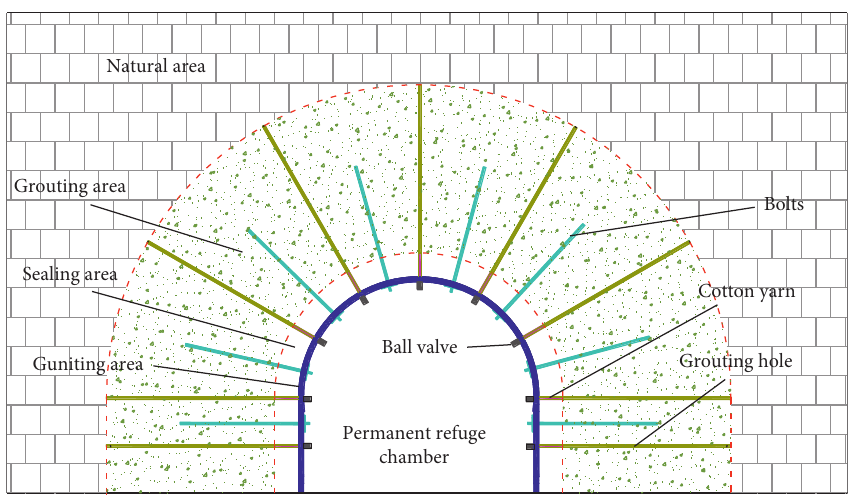
Figure 6: The layout of grouting hole of the permanent refuge chamber.